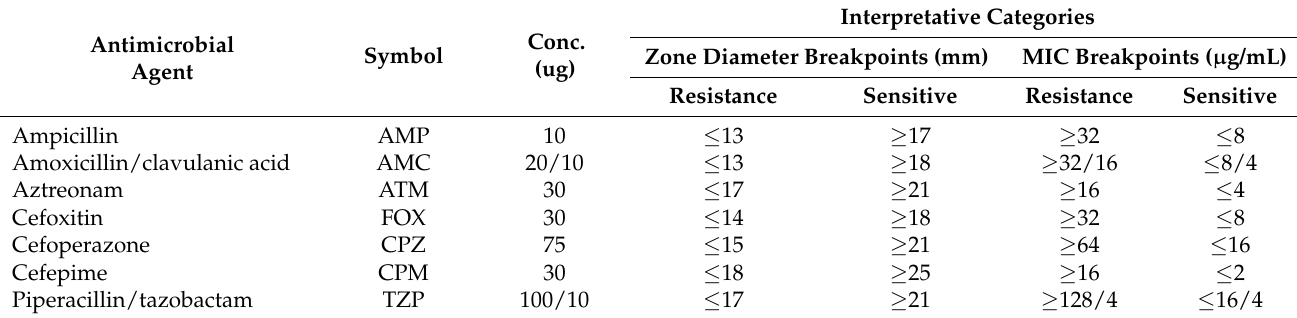
Table 2. Zone diameter and MIC breakpoints for diarrheagenic E. coli